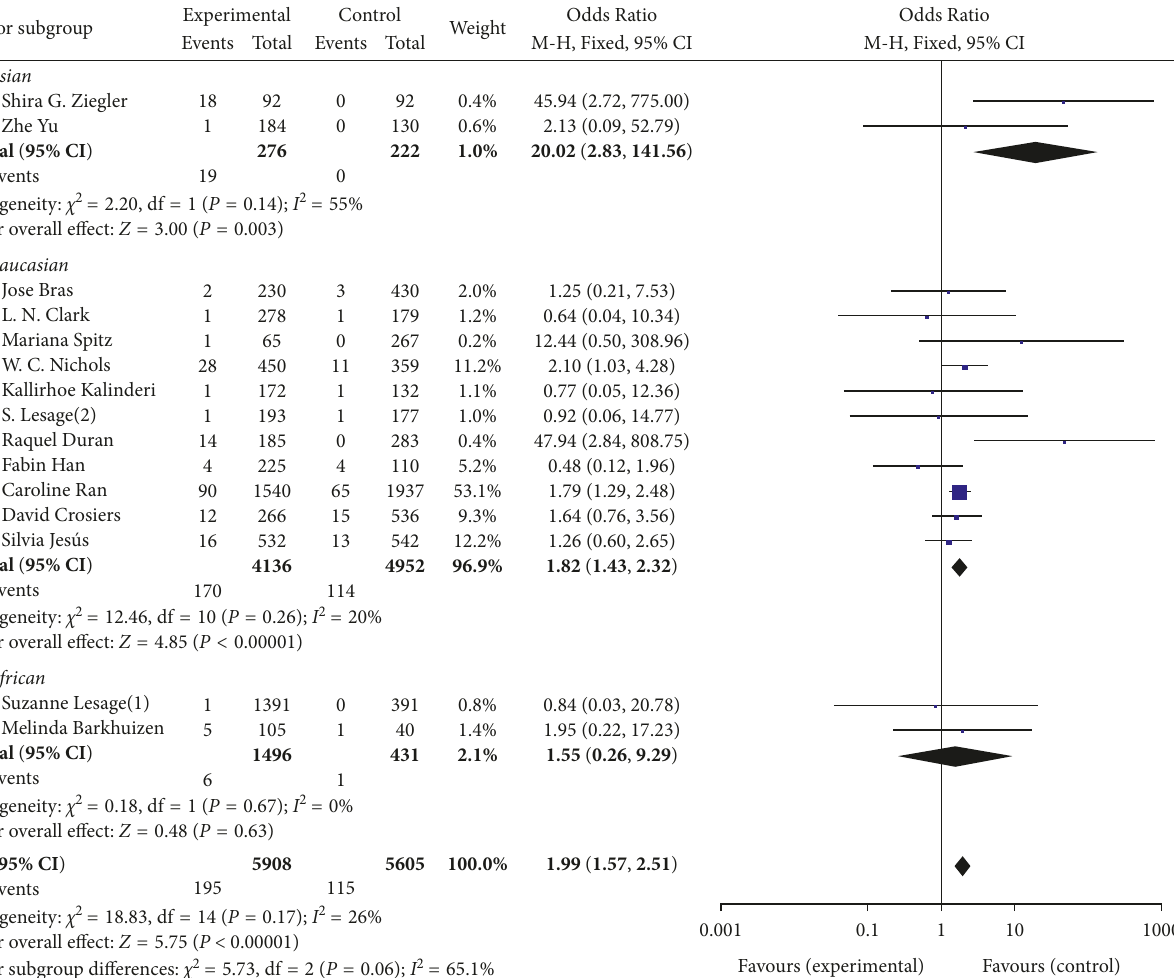
Figure 2: Forest plot of genotype analysis for E326K in